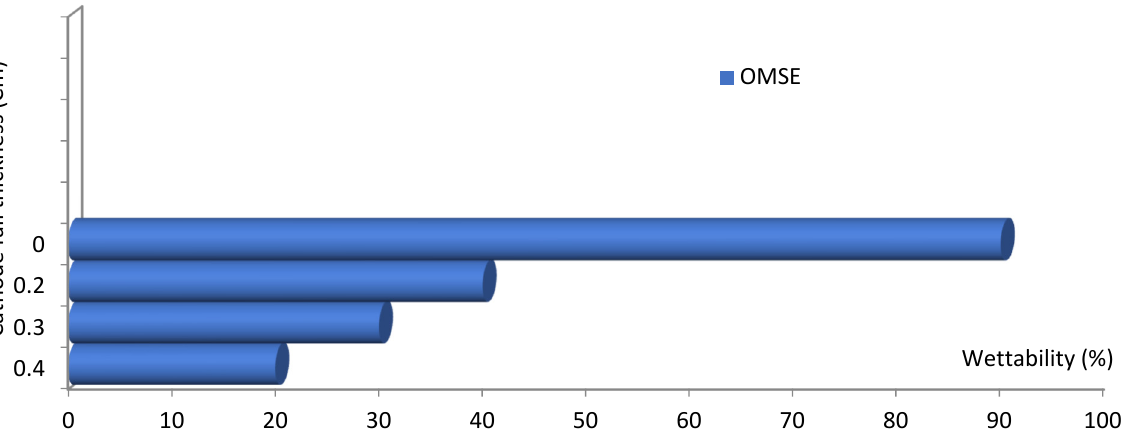
Figure 11. The wettability of the surgical gown (%) as a function of cathode fall thickness (cm) for plasma cell configuration OMSE at applied pressure of 1 mTorr and exposure time of 120